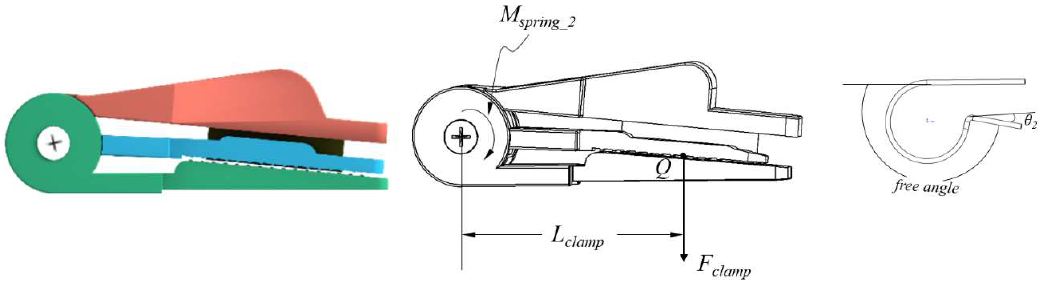
Figure 5. Force diagram of the middle plate touching the bottom plate.